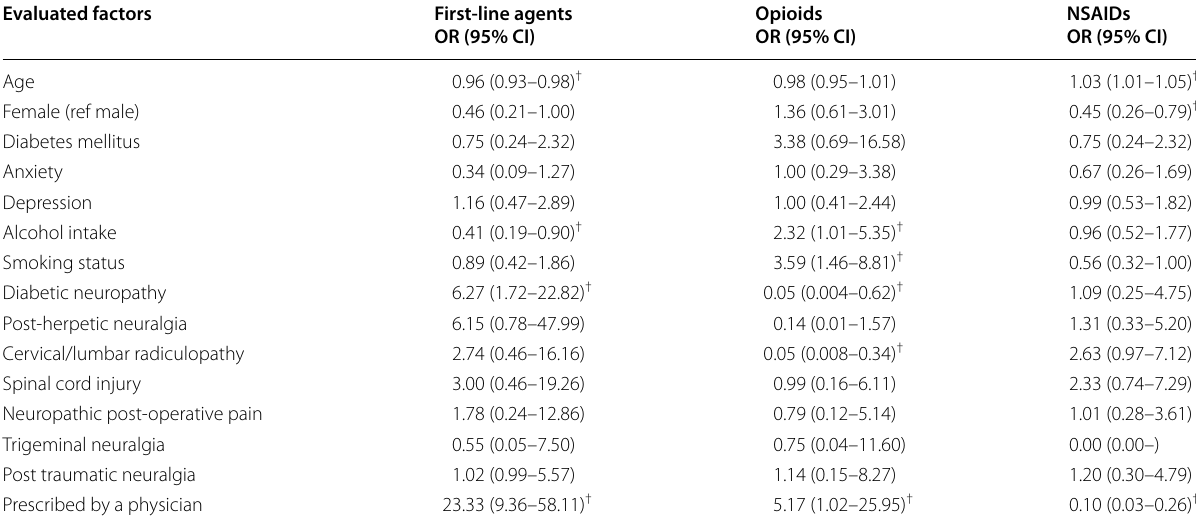
CI confidence interval, NSAIDs nonsteroidal anti-inflammatory drugs, OR odds ratio † p <